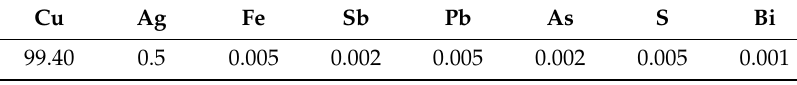
Table 1. Chemical composition of pure copper (wt %).